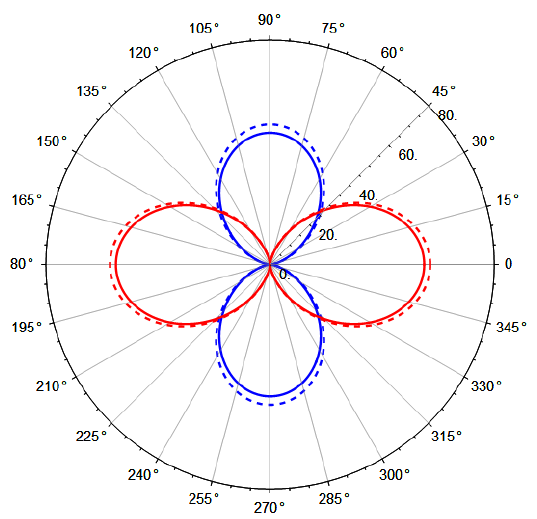
Figure 5: Comparison between the angular dependence of the residue of σ xx at fixed ζ = 0.5 for viscous fluid (solid-lines) and ideal fluid (dashed lines). The poles ω and ω are shown by blue and red color. Spectral weights are larger for ideal fluid 2 of